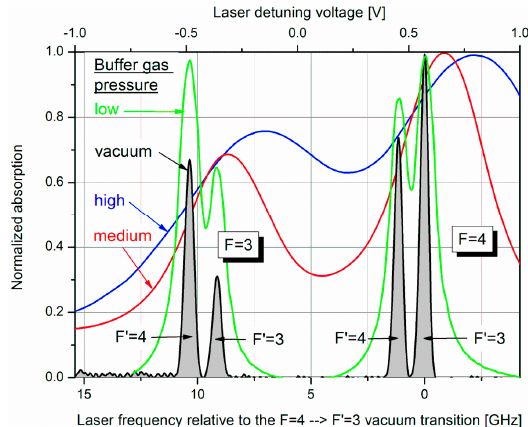
Figure 2. Absorption spectra of Cs cells with different N 2 buffer gas pressure. For the determination of the respective pressure the absorption spectra were fitted by Lorentz profiles. Using the data from Couture [32], broadening as well as shifting of the absorption lines with reference to a vacuum cell delivered consistent values of 20, 125, and 250 mbar at 130 °C for low, medium, and high pressure, respectively. All absorption curves are normalized to their individual maximum.